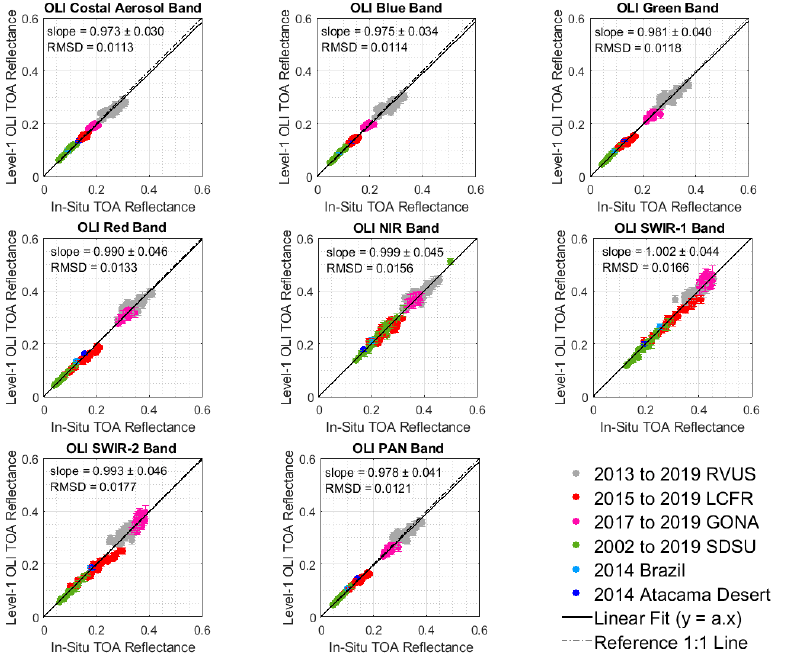
Figure 13. Scatterplots by band of Landsat-8 OLI Level-1 TOA reflectance data versus TOA reflectance values derived from in situ measurement.